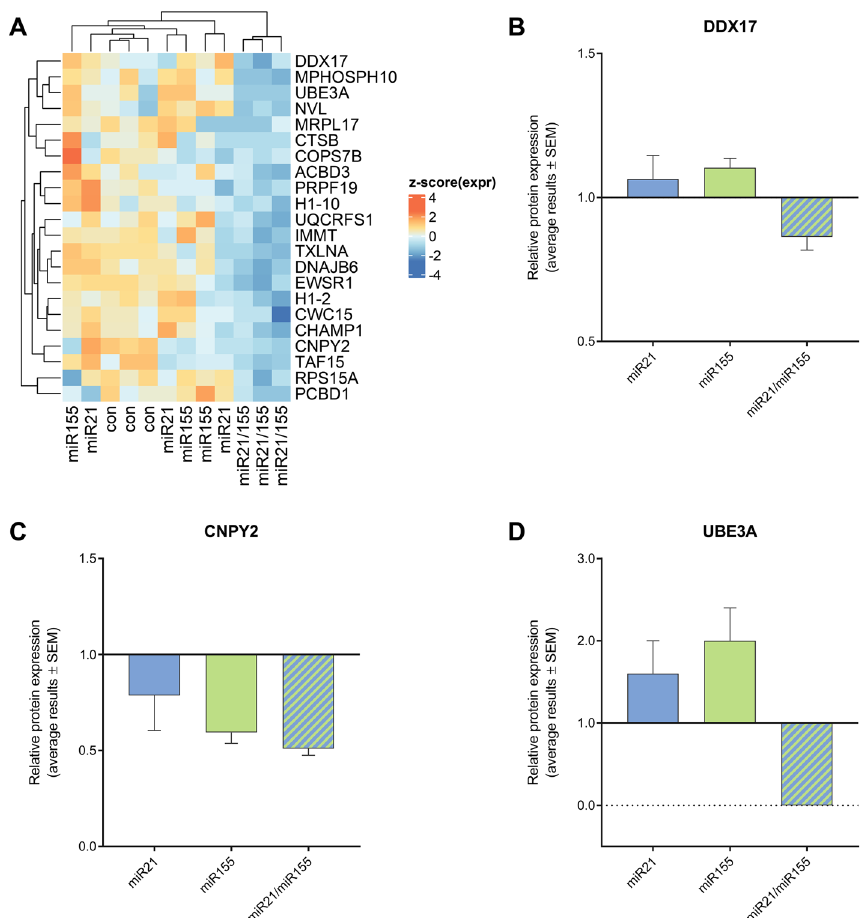
Fig. 4 Analysis of miRNA cooperativity by proteome data. Whole cell protein extracts from 293T human embryonic kidney cells were analyzed by high‑resolution mass spectrometry upon (i) control plasmid transfection (con), (ii) overexpression of only miR‑21‑5p (miR21), (iii) only miR‑155‑5p (miR155) or (iv) upon co‑expression of both miRNAs (miR21/155). Three independent transfection experiments were performed. As defined by the comparison of effect sizes by Cohen’s d, 22 gene products indicated cooperative miRNA effects ( A ; clustering of z‑scored expression data). For specific representation, relative protein expression data for DDX17 ( B ), CYPN2 ( C ) and UBE3A ( D ) were normalized to controls and are shown as averaged results with